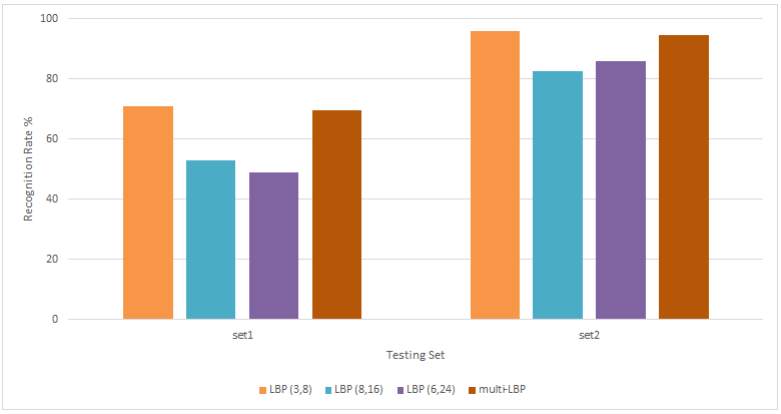
Figure 9. Results of experiments conducted using different LBP neighbourhoods.